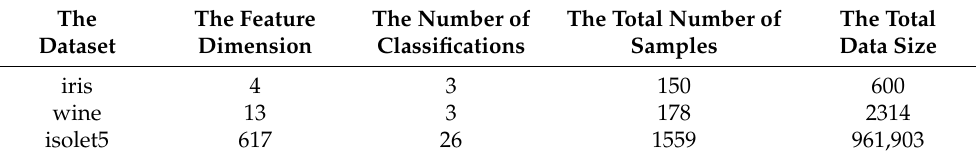
Table 3. The UCI test